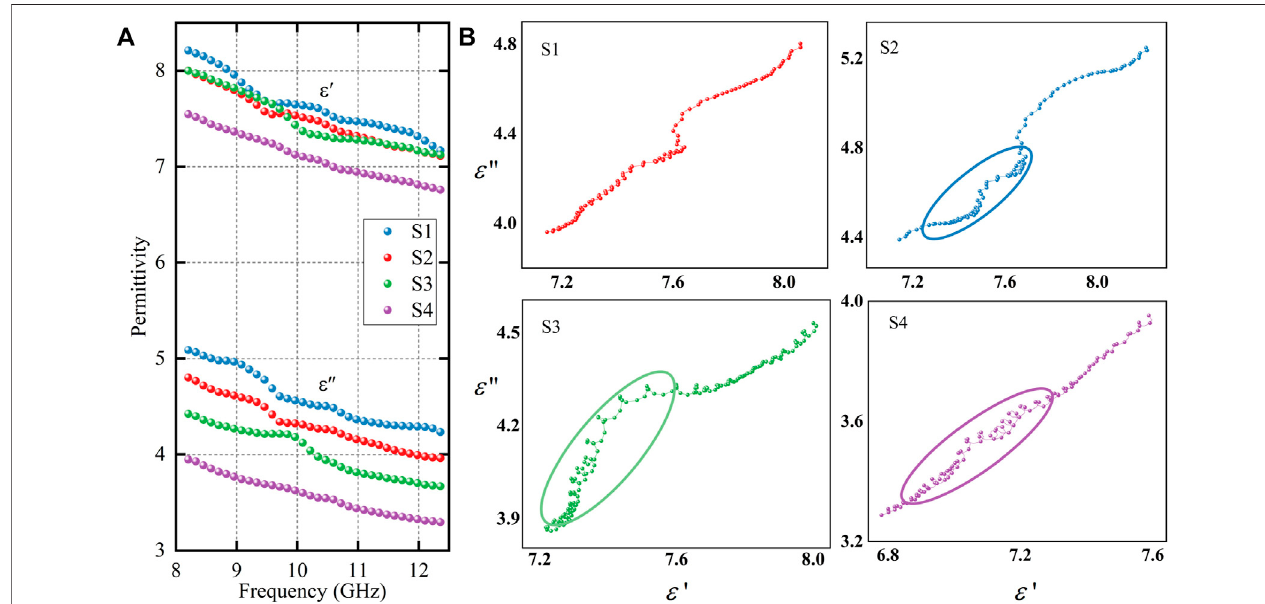
FIGURE 7 | (A) Complex permittivity (B) Cole-Cole plots for four samples.